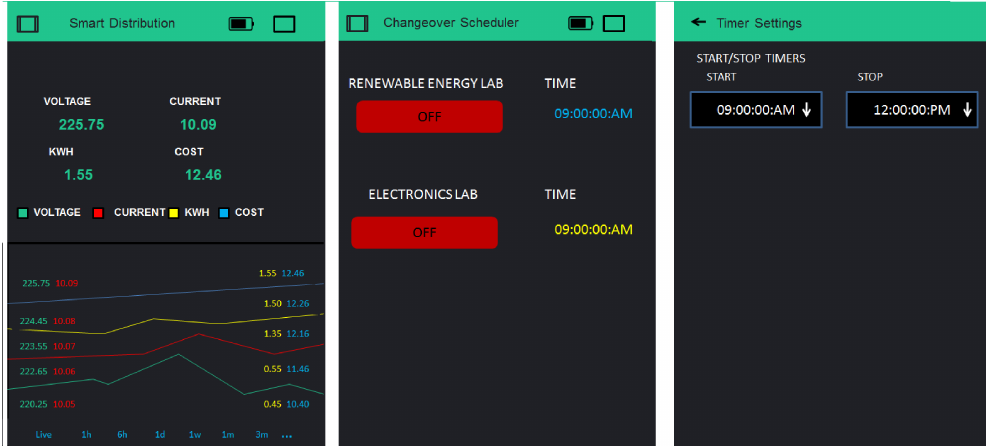
Figure 15. Electrical parameter readings, changeover scheduler, and changeover